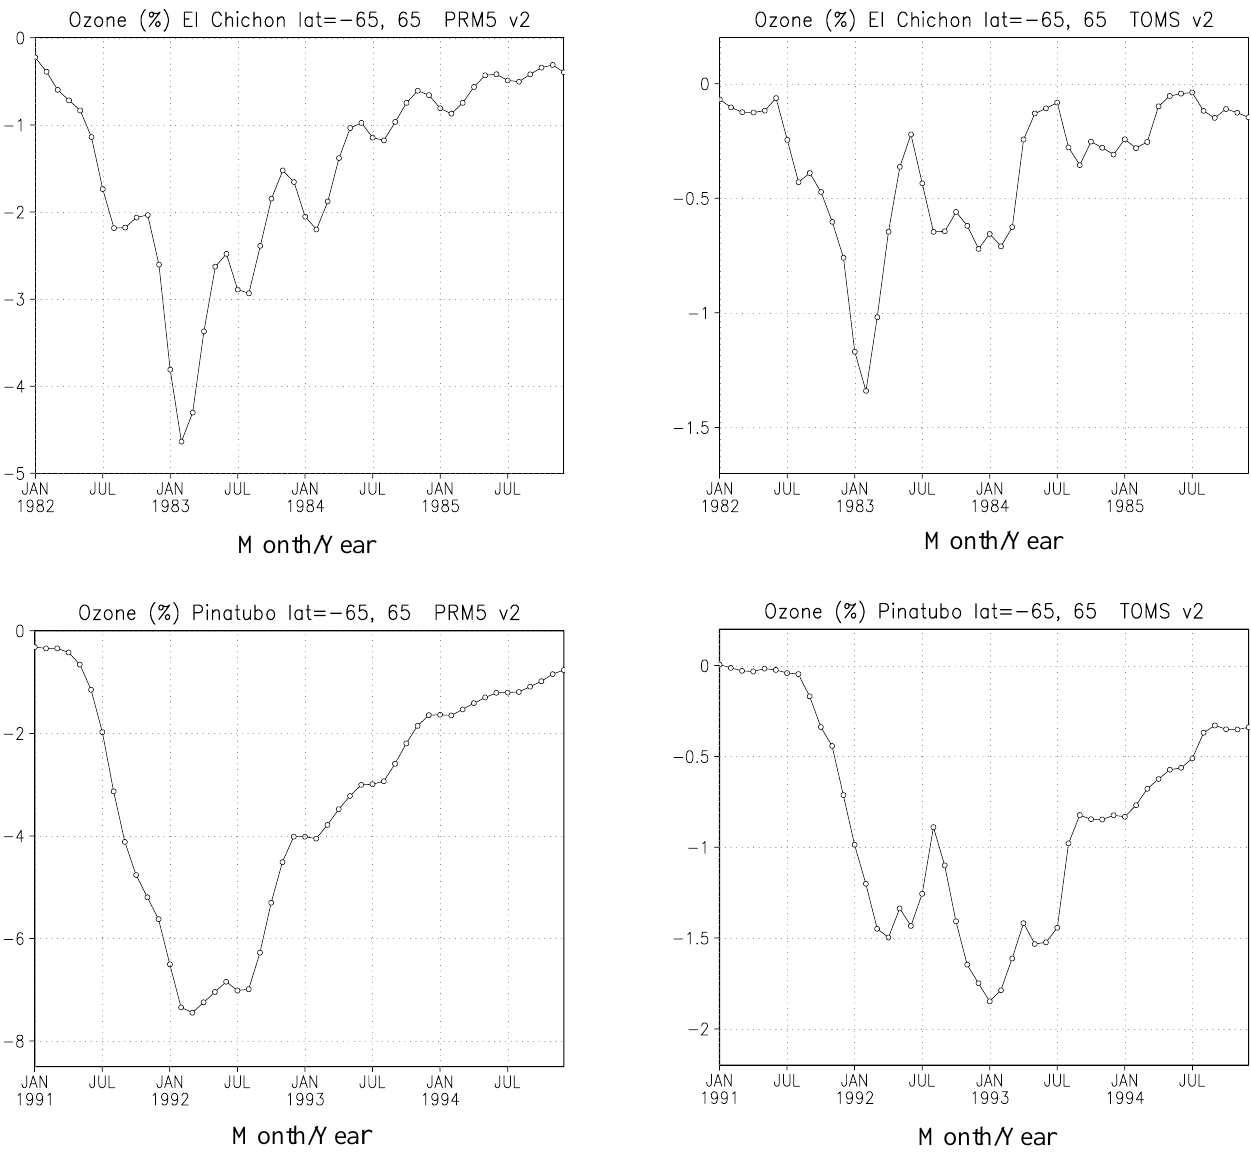
Fig. 19. Evolution of the global total ozone after the El Chich´on eruption from 1982 to 1985 (upper) and Mount Pinatubo eruption from 1991 to 1994 (lower) for the simulation (left) and observation (TOMS/SBUV)